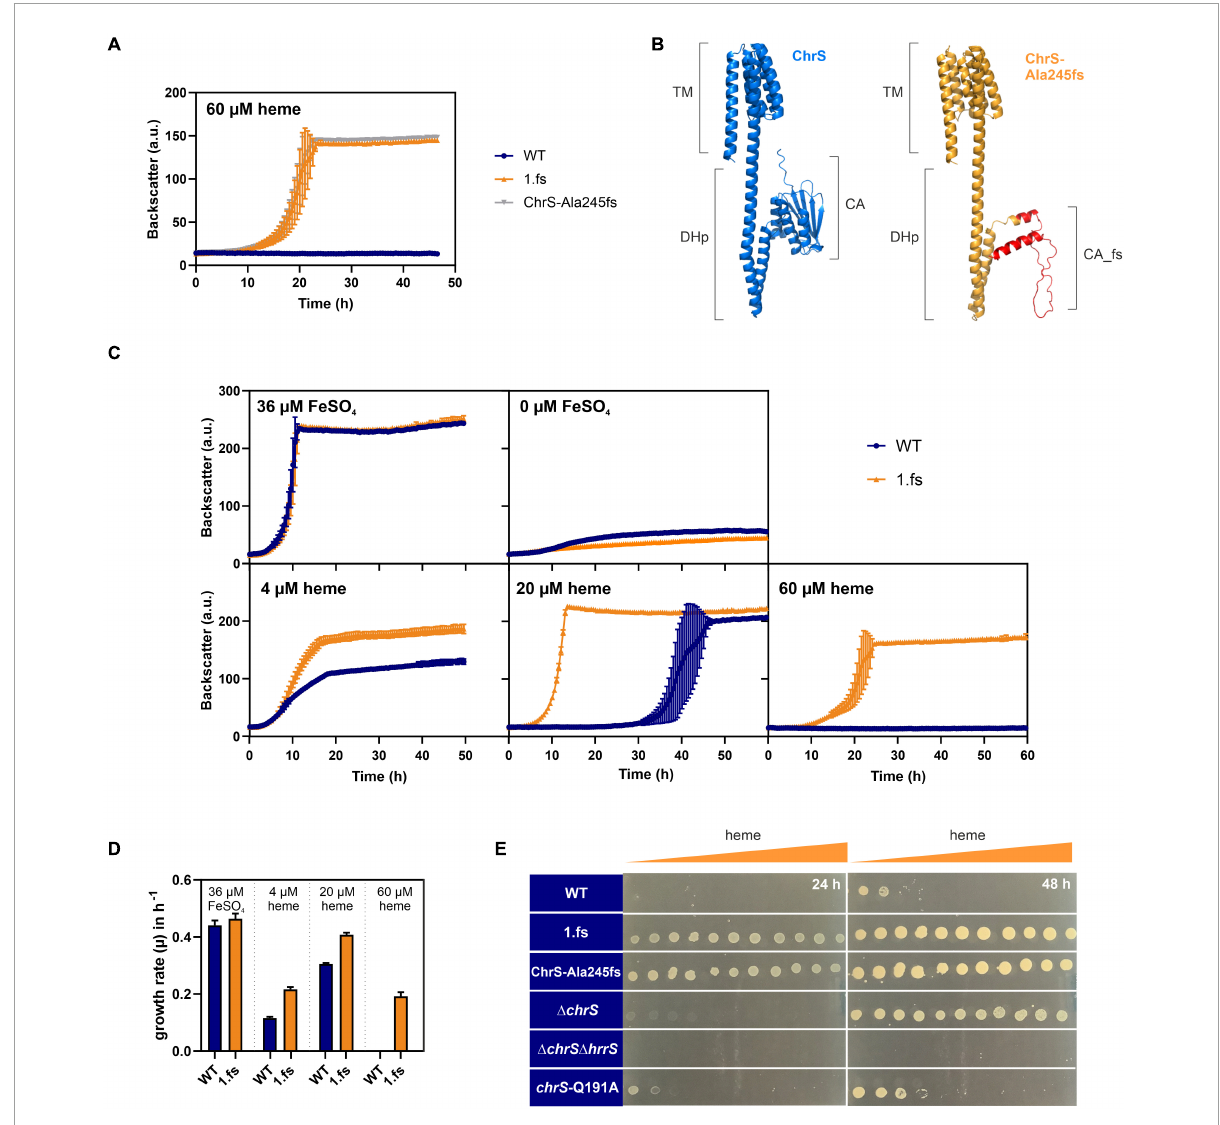
FIGURE3 The ChrS-Ala245fs pseudokinase promotes heme tolerance. Data represent the average of three biological replicates including standard deviations depicted as error bars. Cells were inoculated at a starting-OD 600 of 1 in CGXII medium containing 2% glucose and the indicated amount of heme or iron. (A) Growth of C. glutamicum carrying the reintegrated ChrS-Ala245fs allele (gray) compared to the evolved clone 1.fs (orange) and the wild type (WT) (blue). (B) Predicted protein structures of ChrS (blue) and the truncated ChrS-Ala245fs variant (orange, with 60 additional amino acids caused by the frameshift, shown in red). Prediction was performed using AlphaFold2 (Jumper et al., 2021; Varadi et al., 2021). Domain arrangements are shown next to the protein structures. TM, transmembrane domain; DHp, dimerization- and histidine-phosphotransfer-domain; CA, catalytic- and ATPase-domain. (C) Growth of the WT (blue) and the evolved clone 1.fs (orange) on different heme and iron concentrations; further conditions shown in Supplementary Figure 2 . (D) Comparison of growth rates µ in h - 1 of WT (blue) and 1.fs (orange) at different heme and iron conditions. (E) Different strains were spotted on heme gradient plates. The WT was compared to the evolved clone (1.fs), the reintegration for the evolved clone (ChrS-Ala245fs), the chrS deletion strain ( (cid:49) chrS ), the chrS and hrrS deletion strain ( (cid:49) chrS (cid:49) hrrS ) and the phosphatase mutant ( chrS -Q191A). Photos of plates were taken after 24 and 48 h. A representative experiment out of three is